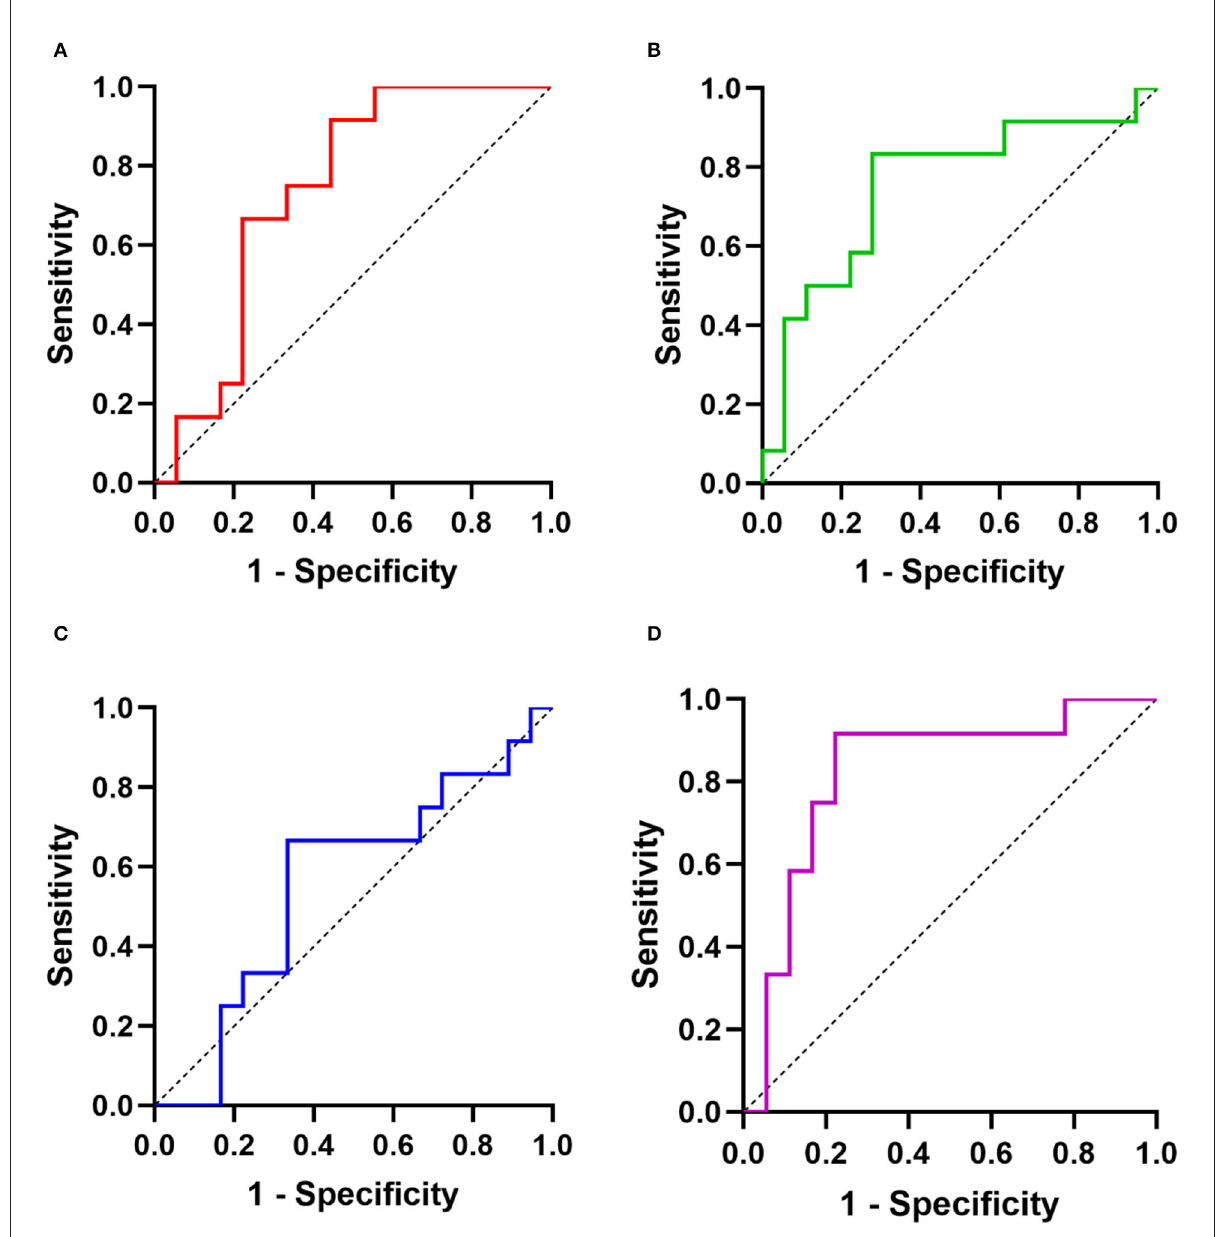
FIGURE3 The diagnostic powers of targeted miRNAs for distinguishing CAD-activated SCD and CAD-silent SCD: ROCs of (A) miR-126-5p; (B) miR-499a-5p; (C) miR-134-5p; (D) combination (miR-126-5p and